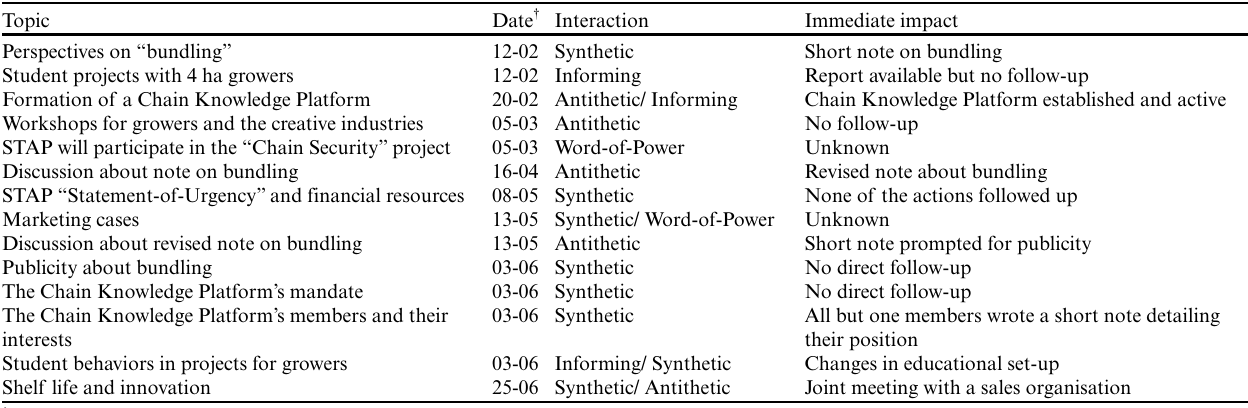
Table 1 . Social learning outcomes